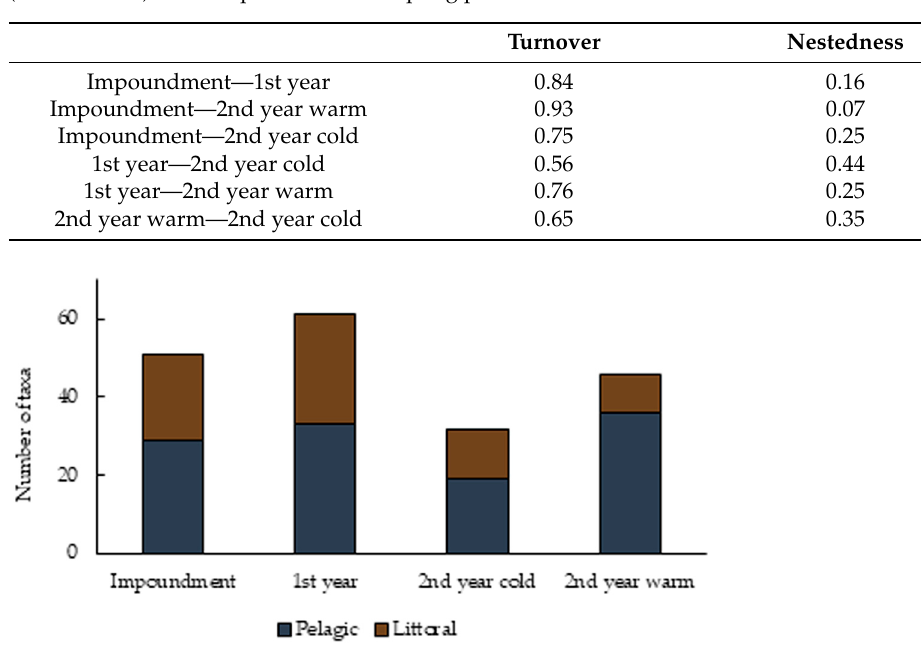
Table 2. Zooplankton beta diversity according to relative turnover (bSIM/bSOR) and nestedness (bNES/bSOR) for each phase of the sampling period.